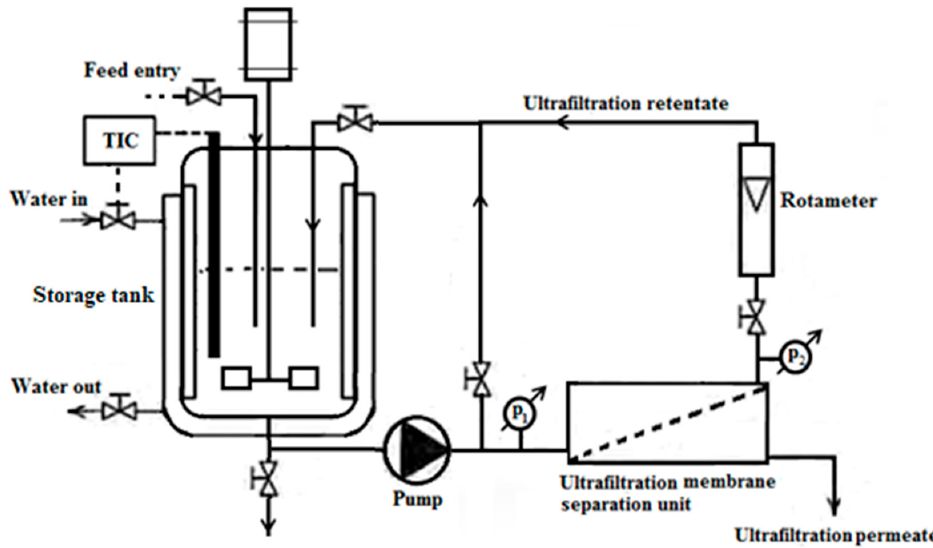
Figure 2. Schematic diagram of the cross-flow membrane module.